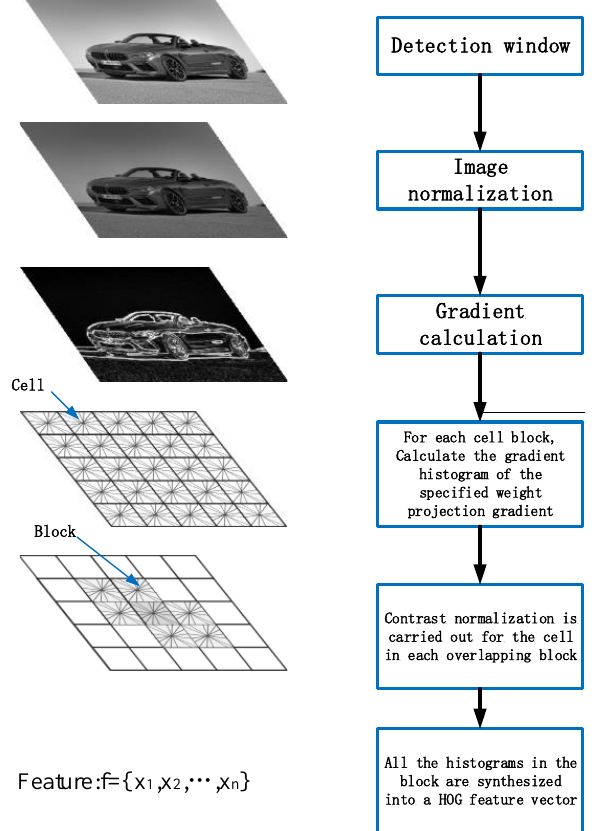
Figure 1. Orientation gradient histogram feature (HOG) processing.